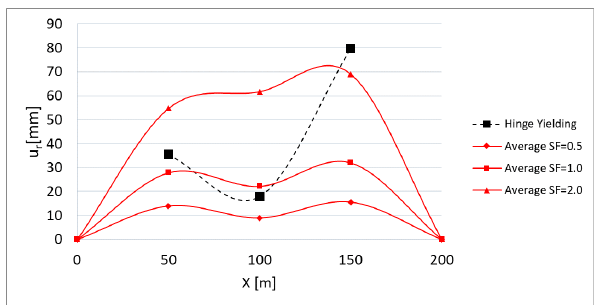
Figure 13. NRHA with scale factor 2.0—deck displacements.